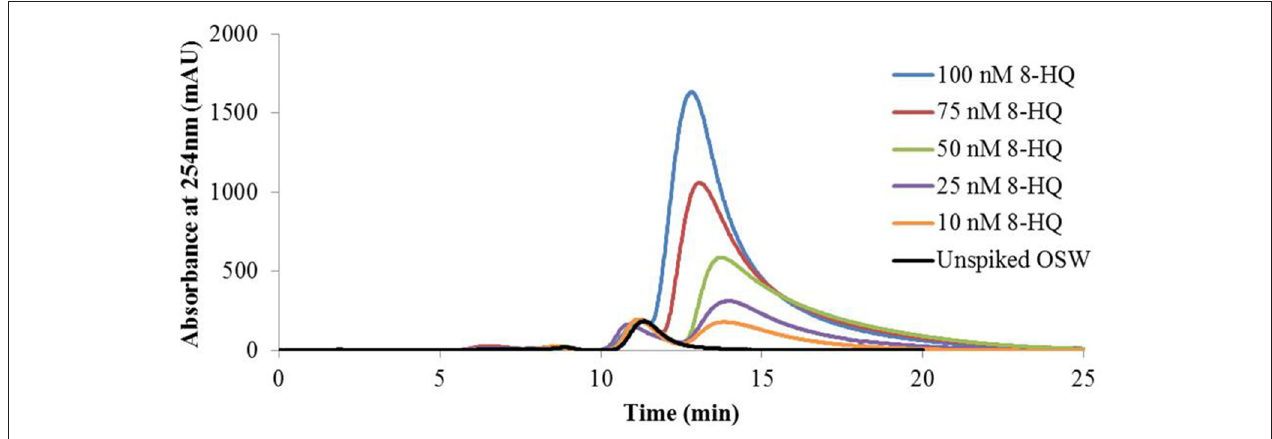
FIGURE 1 | Immobilized copper(II)-ion affinity chromatography (Cu(II)-IMAC) of oceanic surface seawater (OSW) spiked with the model ligand 8-hydroxyquinoline (8-HQ). One-liter OSW samples containing up to 100 nmoles of added 8-HQ were fractionated by Cu(II)-IMAC while monitoring UV absorbance of the eluent at 254nm using the LKB system (see text). All samples gave rise to a peak at 11 min, attributed to natural copper ligands present in OSW, whereas samples spiked with 8-HQ gave rise to a second elution peak at 12–14 min with area proportional to the amount of ligand added to the OSW sample ( r 2 = 0.9927).